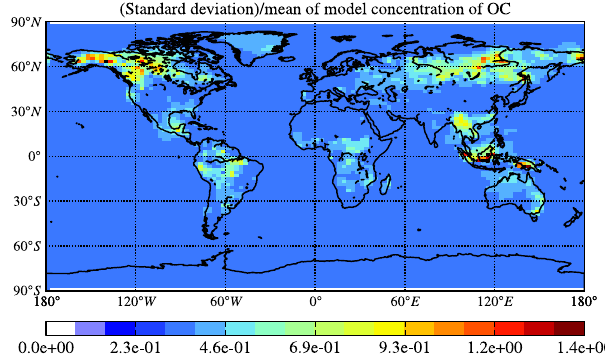
Figure 5. Spatial distribution of the ratio of the standard deviation to the mean of all model simulations, based on annual mean of the computed surface OC